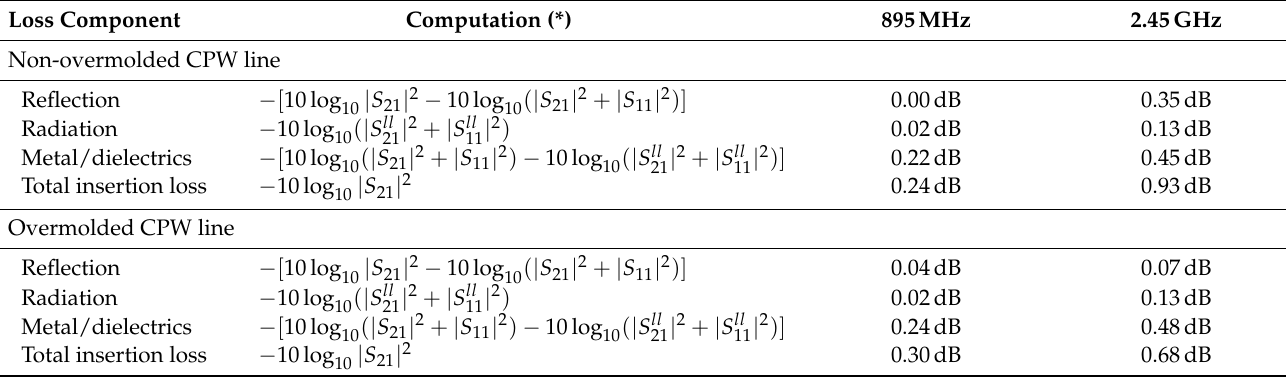
Table 1. Insertion loss of CPW line